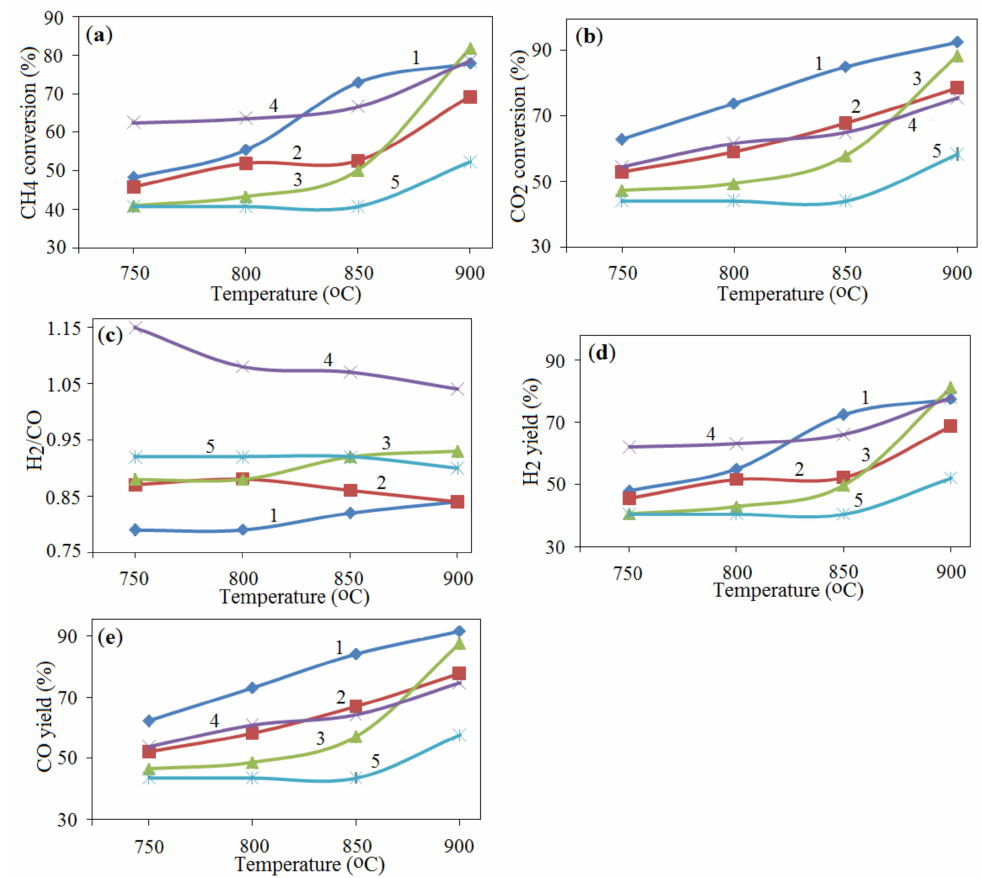
Figure 13. Dry reforming of methane on NiO–Al-Al 2 O 3 catalysts with different ratios of